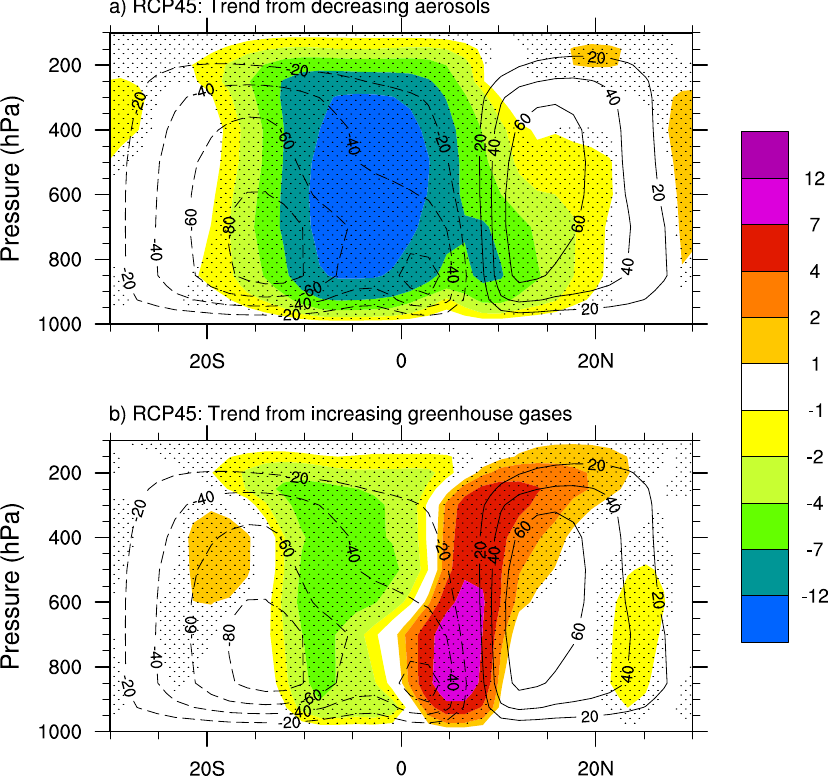
Fig. 8. 2006–2100 trends (10 9 kgs − 1 per century) in annual-mean meridional streamfunction (shaded) from (a) RCP45 minus RCP45A2005, and (b) RCP45A2005. Contours show the climatology from HIST, averaged over 1986–2005 (10 9 kgs − 1 ). Positive numbers denote clock- wise circulation. Stippling denotes changes significant at 5%, based on a two-sided t test.